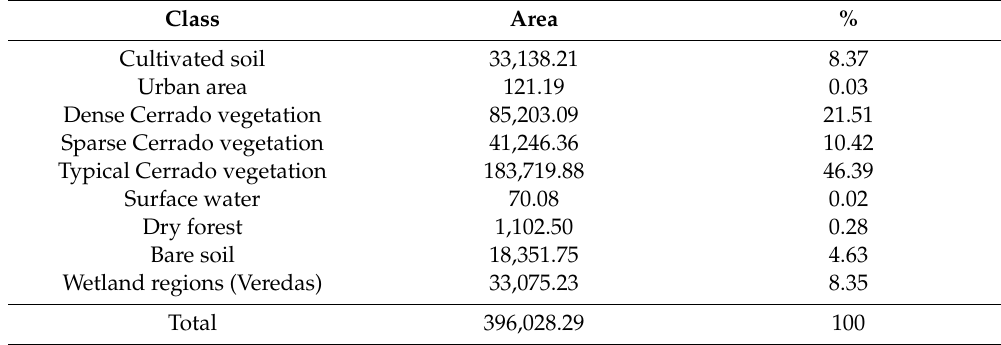
Figure 5. Land use and cover map of the study area, Pandeiros River basin. Table 5. Spatial distribution and proportion of the land use and cover classes in the Pandeiros River basin.